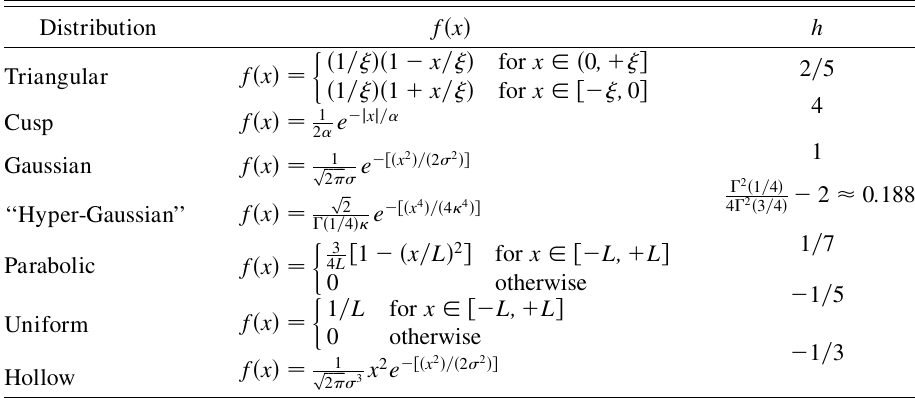
TABLE II. Profile parameter values for 1D distributions. Distribution